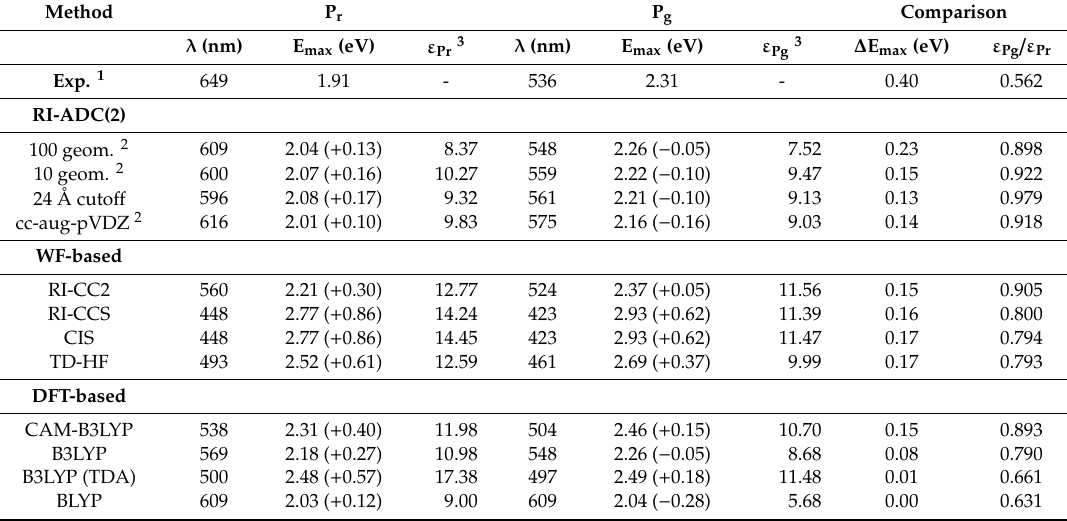
Table 2. Lowest energy absorption maxima of P r and P g . Wavelengths ( λ ), energies (E max ), energy di ff erences in parenthesis and absolute absorption ( ε Pr and ε Pg ) as well as photoproduct tuning ( ∆ E max ) and ratio of absorption intensities ( ε Pg / ε Pr ) are tabulated. The QM region consisted of 66 atoms and if not stated otherwise, the results are based on 10 snapshots taken every 100 ps. The cc-pVDZ basis set was utilized and a cuto ff of 12 Å to any of the QM atoms was employed to take the environment as point charges into